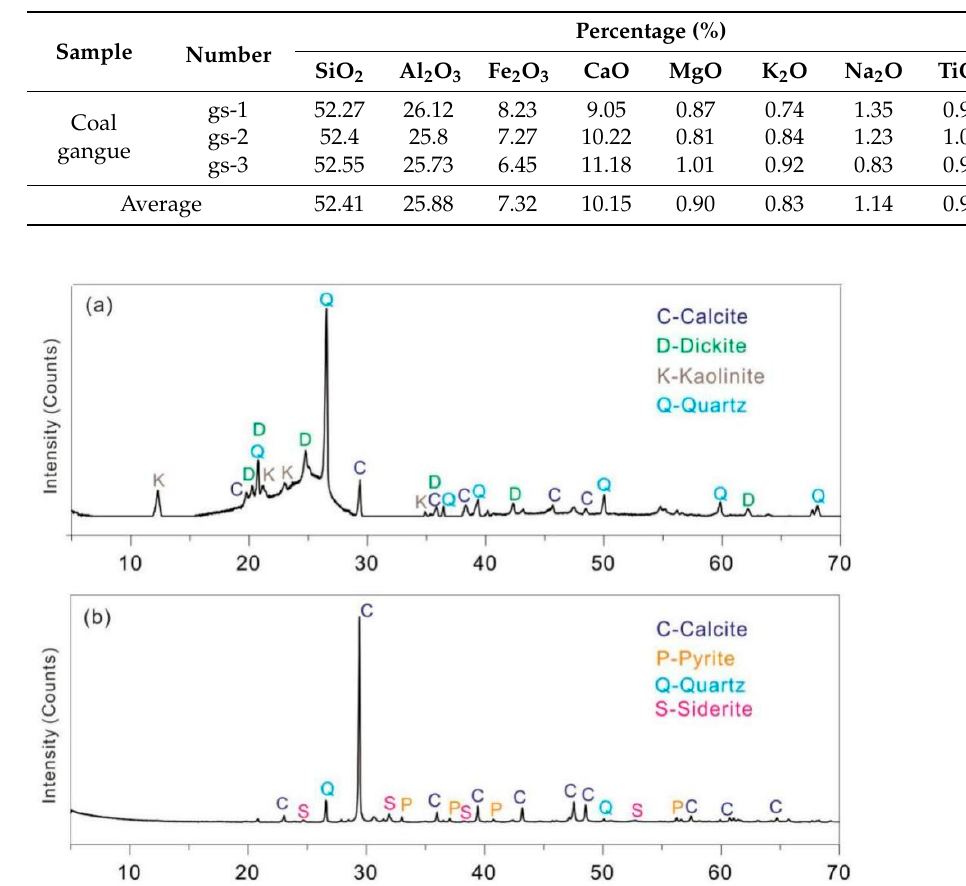
Table 2. Proportion of major components of coal gangue.